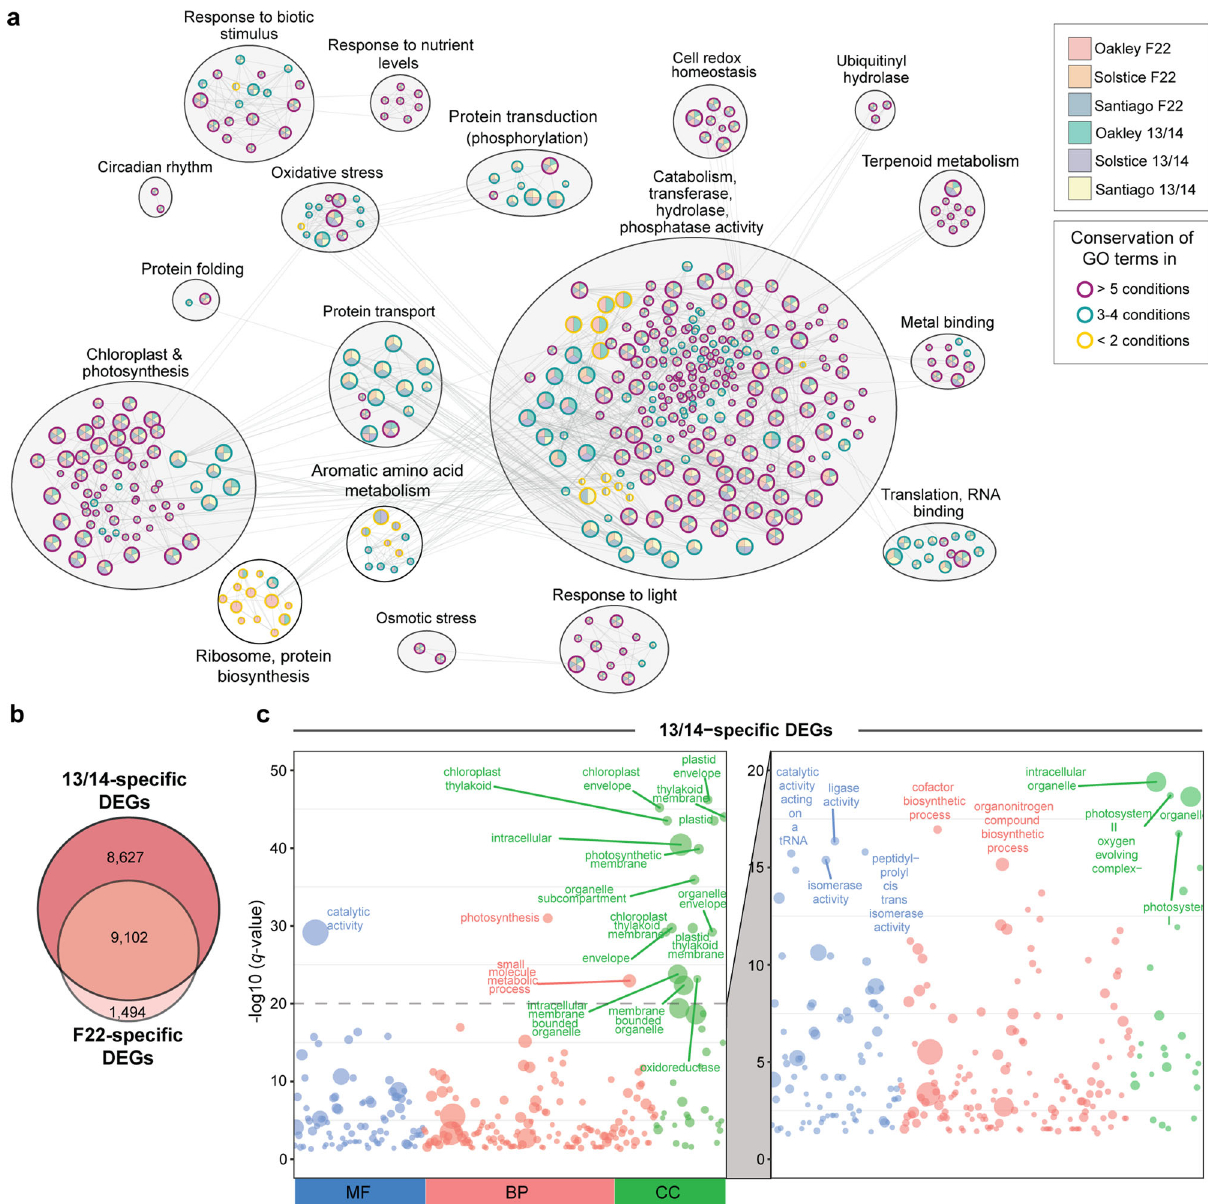
isolate F22. c Functional GO term enrichment analysis results for the 8627 Pst 13/14-speci fi c DEGs. GO terms were annotated when – Log( q -value) > 20 ( fi rst panel) or – Log( q -value) > 15 (second panel). Circle size represents the number of genes annotated within the particular enriched function;